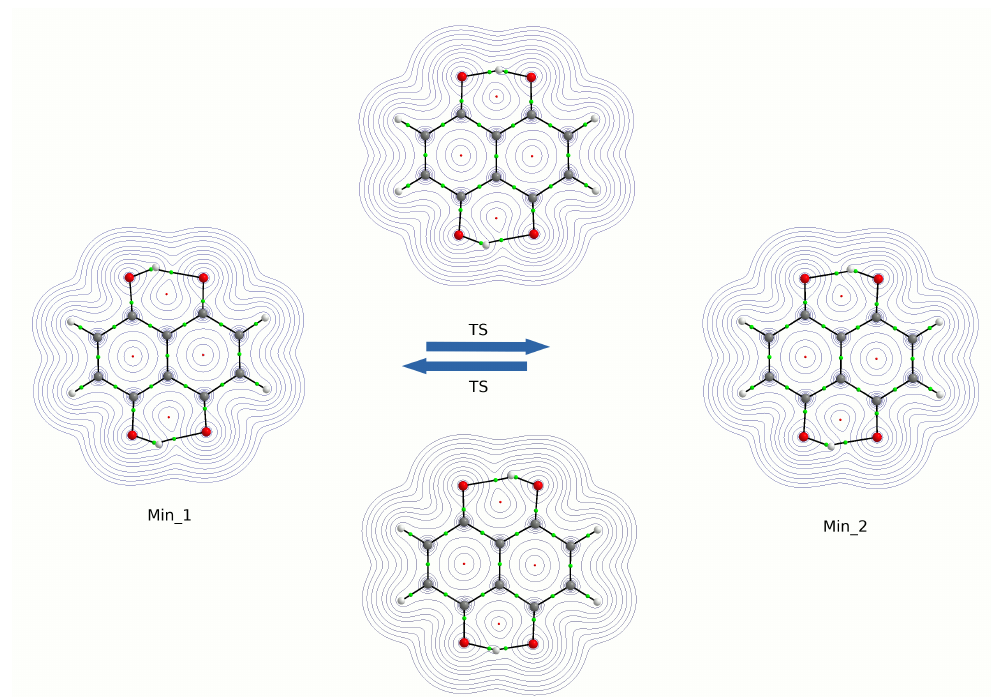
Figure 6. AIM topology maps of the proton transfer reaction model of Naphthazarin on the basis of CAM-B3LYP/6-311+G(2d,2p) level of theory. The black solid and dashed lines indicate the presence of intramolecular interactions. Green and red dots mark the presence of BCPs and RCPs detected by the analysis.